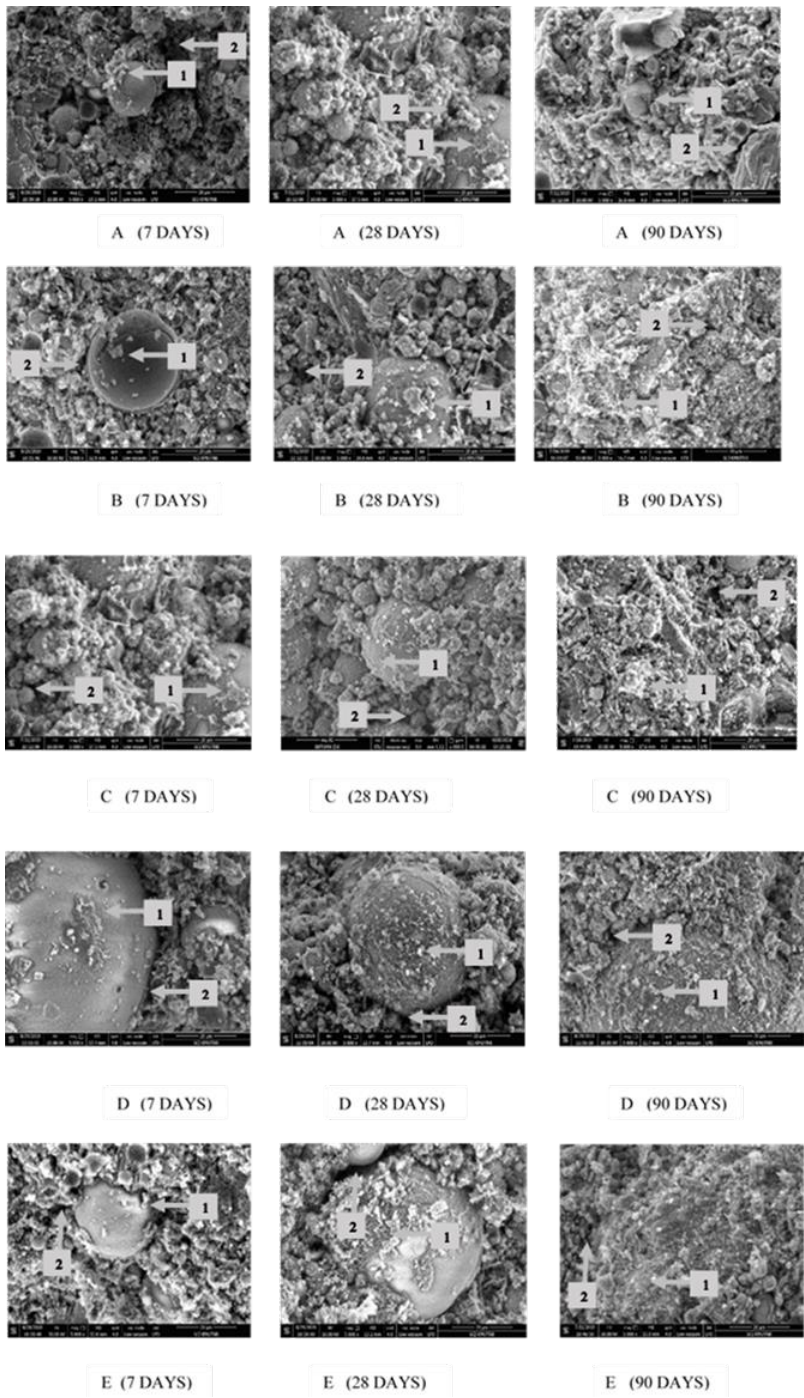
Figure 10. SEM micrographs of hydrated FA blended cement at 7, 28 and 90 days showing layered Ca(OH) 2 around FA (point 1) and the air voids (point 2): varying α-Fe 2 O 3 of ( A ) FA40, ( B ) C1, ( C ) Ca(OH) 2 around FA (point 1) and the air voids (point 2): varying α -Fe 2 O 3 of ( A ) FA40, ( B ) C1, SDS, ( D ) CTAB and ( E ) TX100. ( C ) SDS, ( D ) CTAB and ( E )